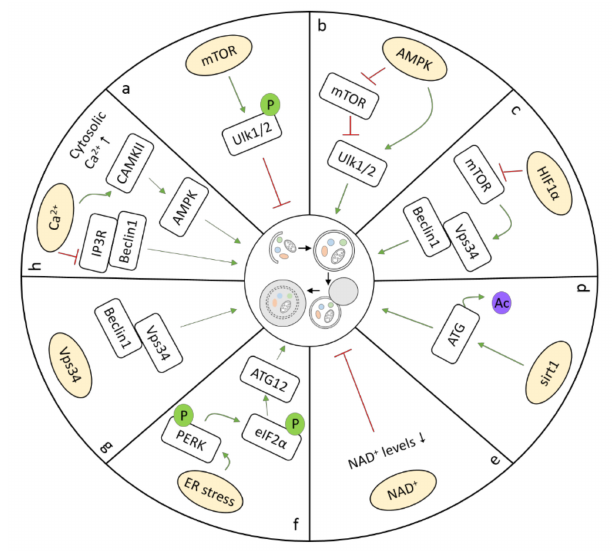
Figure 2. Different pathways activate autophagy: ( a ) mTOR, ( b ) AMPK, ( c ) HIF1 α , ( d ) sirt1, ( e ) NAD + , ( f ) ER stress, ( g ) Vps34, and ( h ) Ca 2+